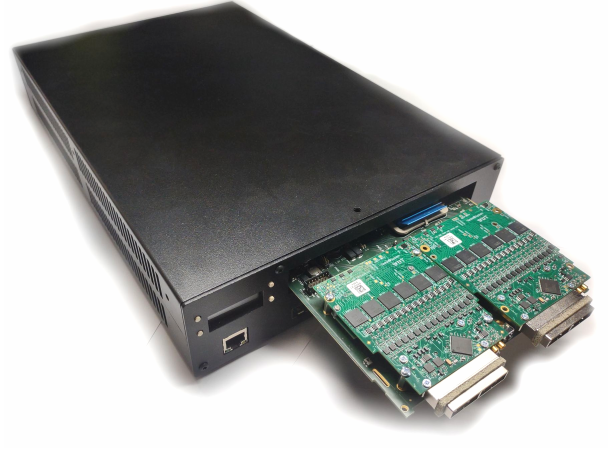
Figure 30. Setup of 2 FMC–ADC–TDC modules (green electronic boards) mounted on AFCK board inside mTCA Chassis (black box). AFCK and modules are temporarily ejected for presenta- tion/maintenance